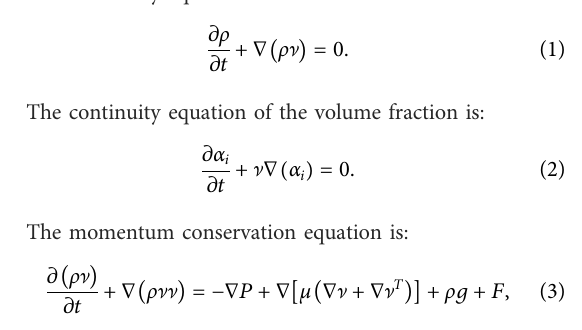
FIGURE 1 Schematic diagram of the groove structure for the super- hydrophilic copper